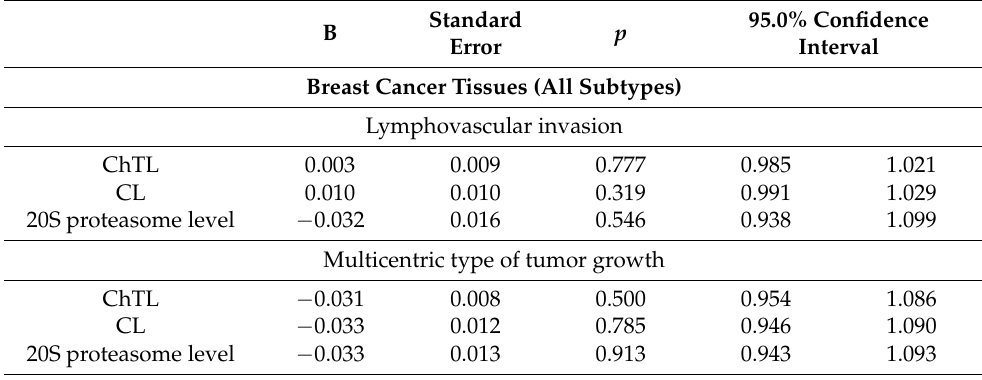
Table 6. The proteasomal activity and the level of 20S proteasome in breast cancer and ovarian cancer: predicting tumor aggressiveness using regression